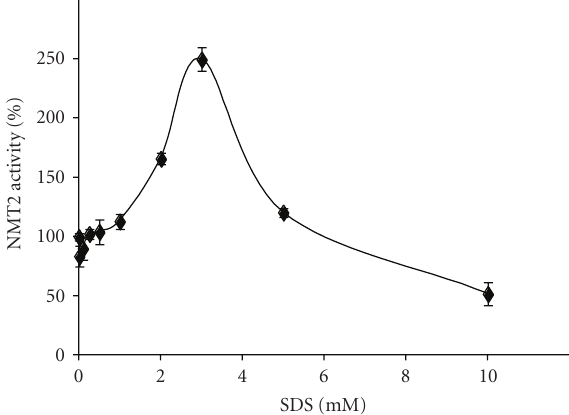
Figure 5: E ff ect of SDS on bovine brain NMT2 activity. Bovine brain NMT2 (1.0 μ g/assay) activity was determined in the pres- ence of carrying concentrations of SDS (0–10mM) using cAMP- dependent protein kinase derived peptide substrate (1.0mM). The reactions were initiated by the addition of 0.27 μ M[ 3 H] myristoyl CoA and incubated at 30 ◦ C for 30 minutes. The data presented are representative of at least three separate experiments.